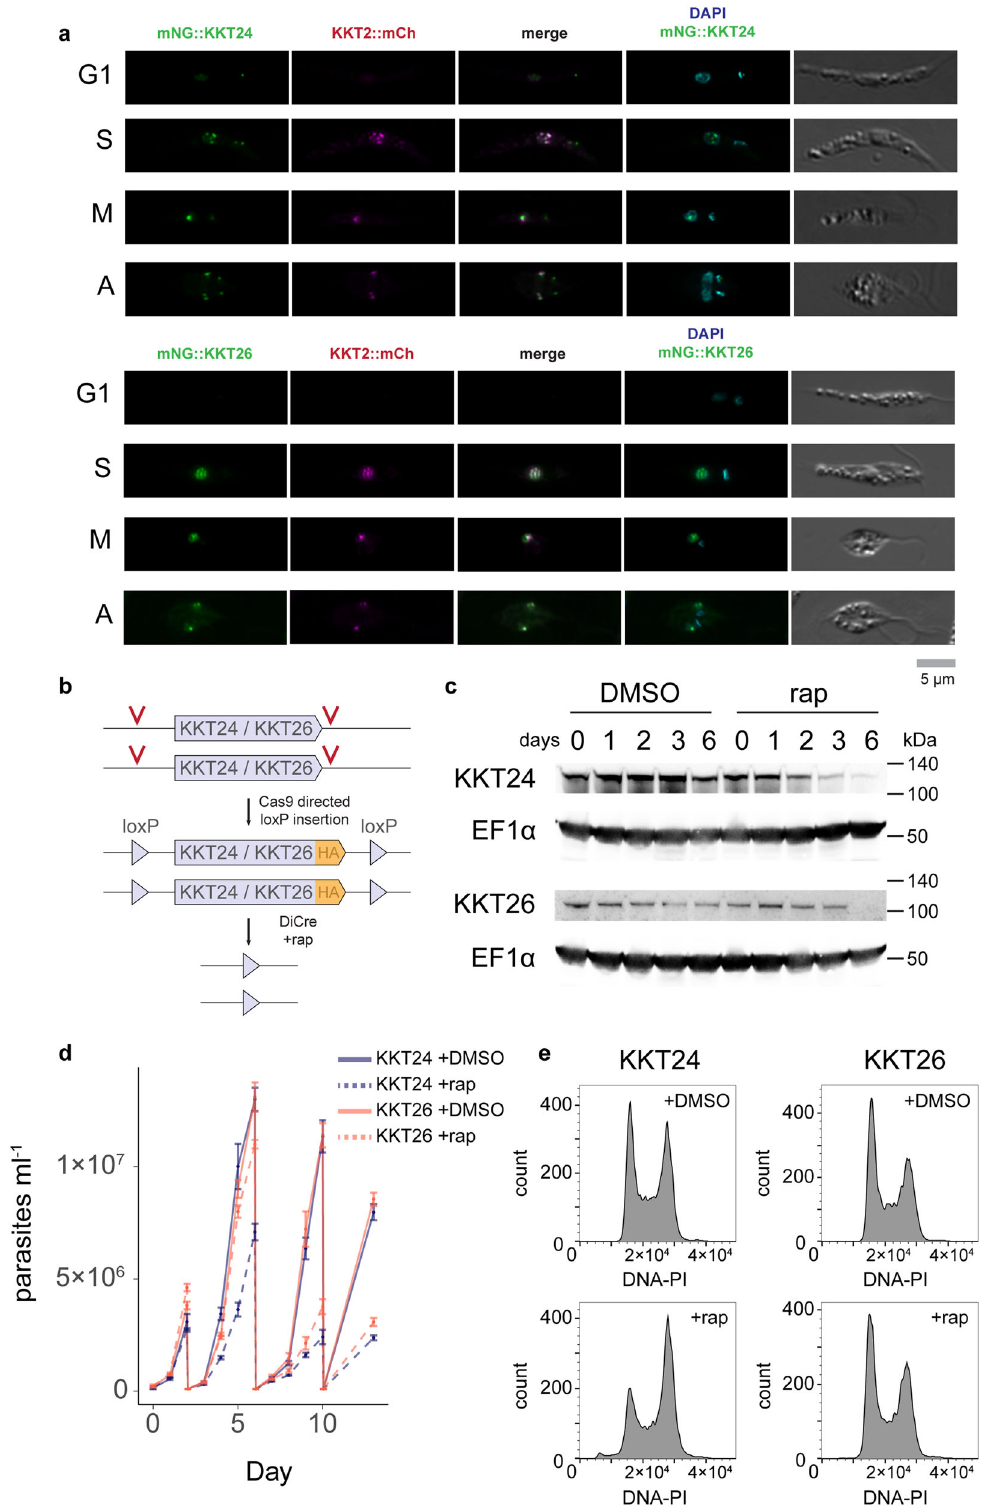
The segregation of duplicated chromosomes during mitosis, dri- ven by kinetochore-mediated attachment of chromosomes to the mitotic spindle, is a tightly orchestrated sequence of events. This reduces the possibility of errors occurring that would ultimately lead to an incorrect complement of genetic material being seg- regated into daughter cells, with potentially catastrophic